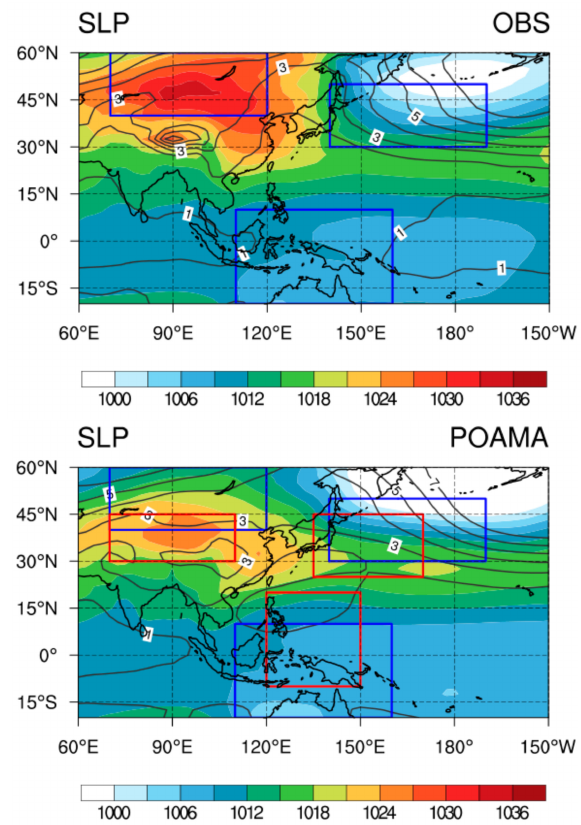
Figure 13. The climatology and standard deviation of DJF mean SLP for the period 1983–2007. The three rectangles with blue and red colors indicate the areas used to define the original and modified EAWM index,